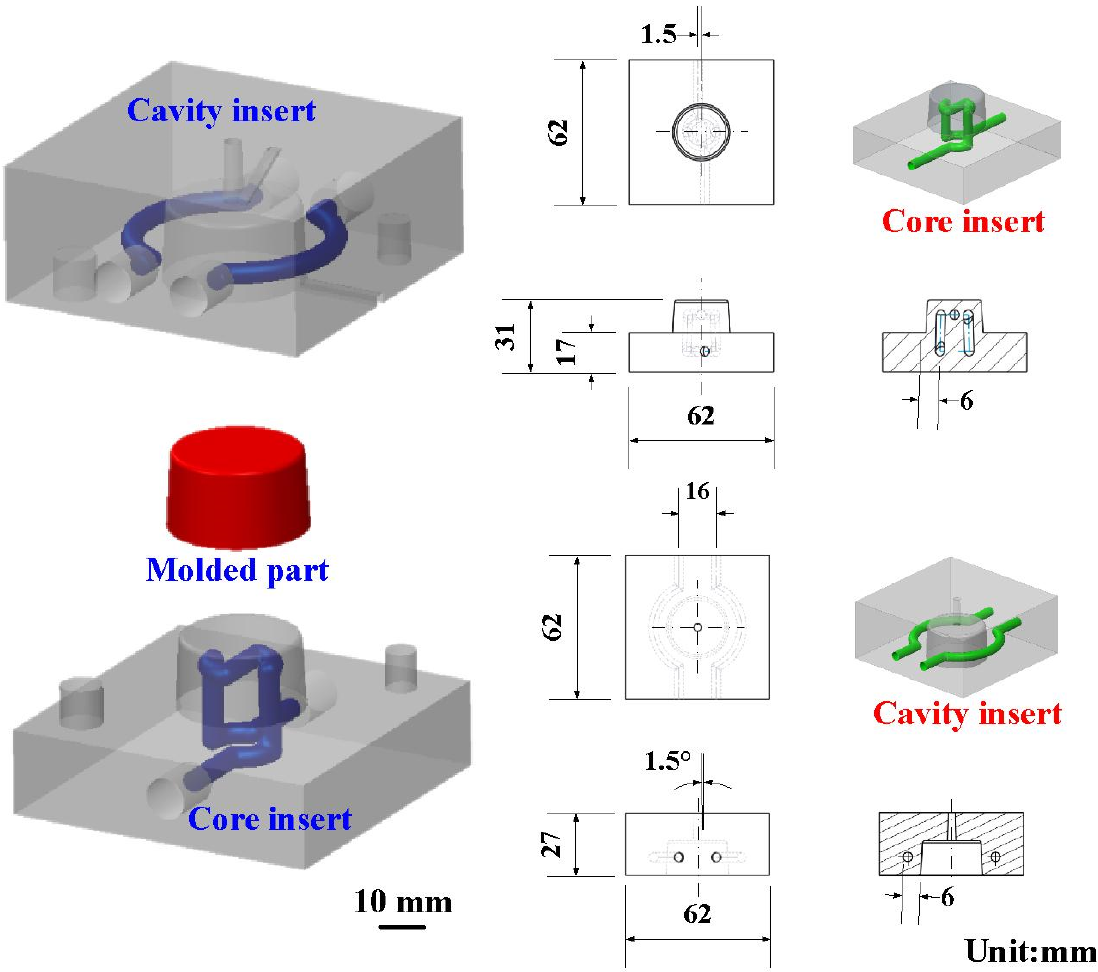
Figure 2. Details of injection mold with CCC. Table 2. Process parameters of 3D printing.